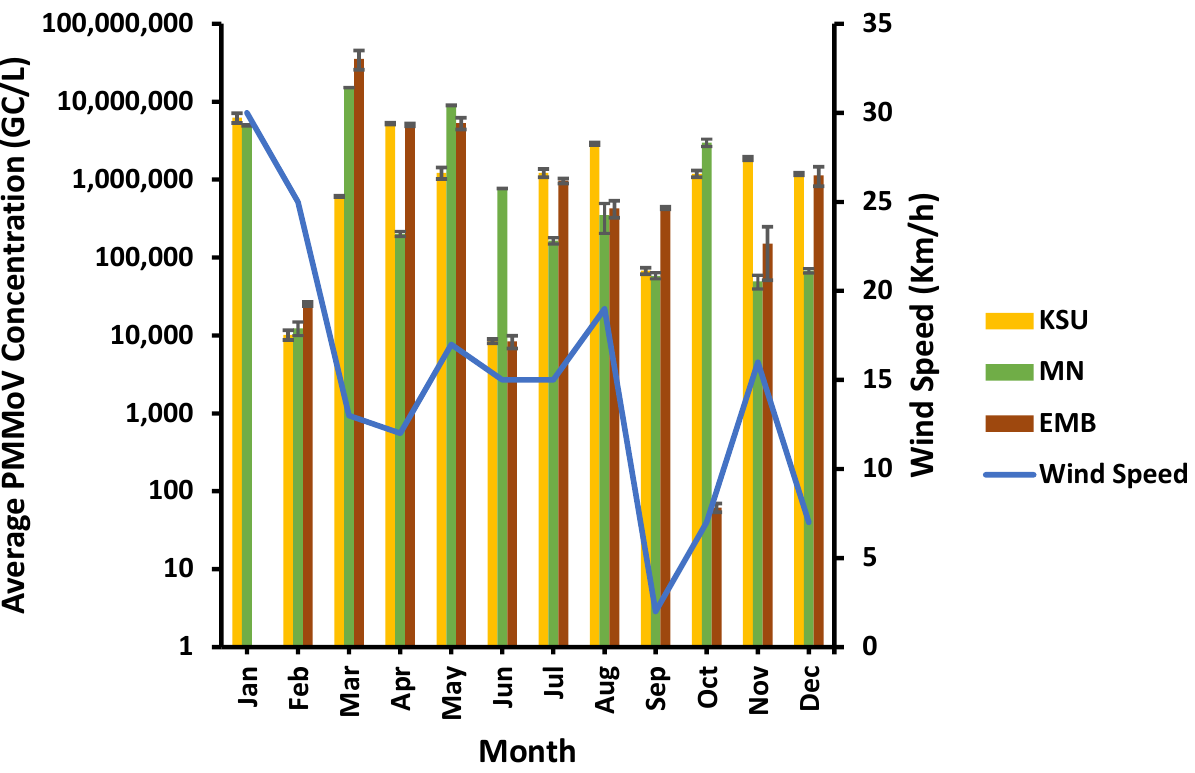
Figure 5. Influence of wind speed variation on the PMMoV concentration.